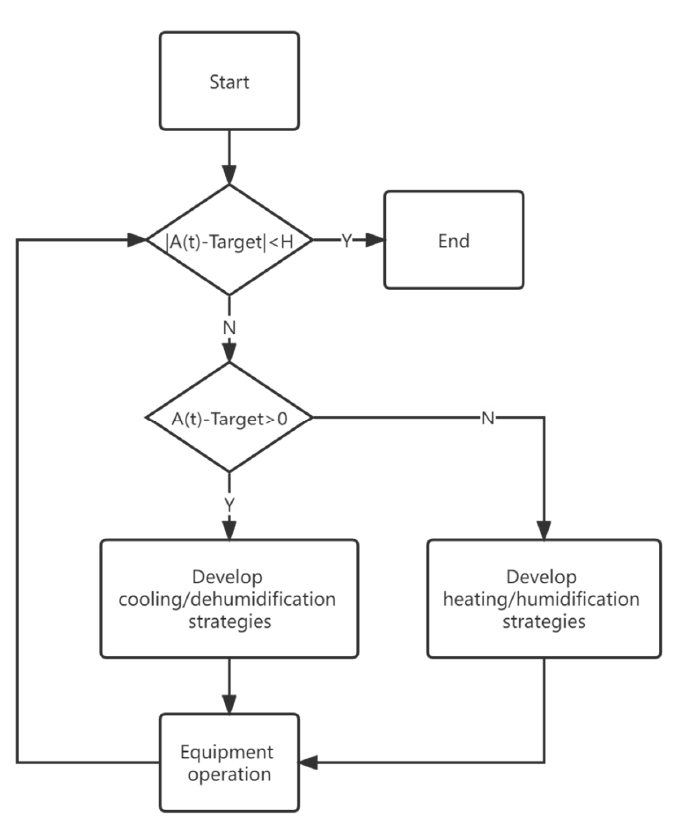
Figure 6. Flow chart of microcosmic regulation of room temperature.